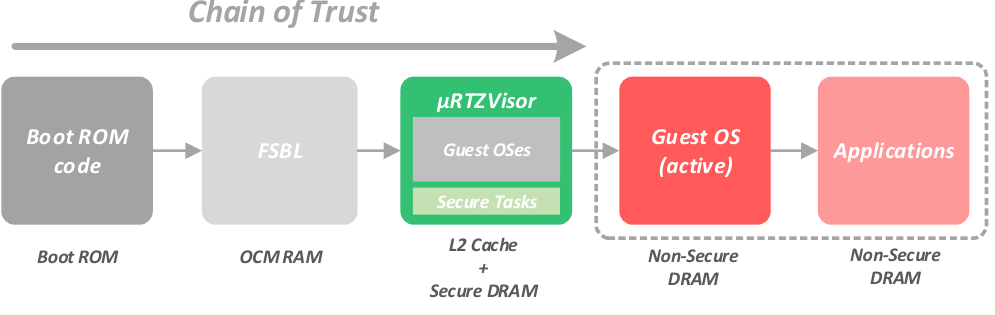
Figure 3. µ RTZVisor: secure boot